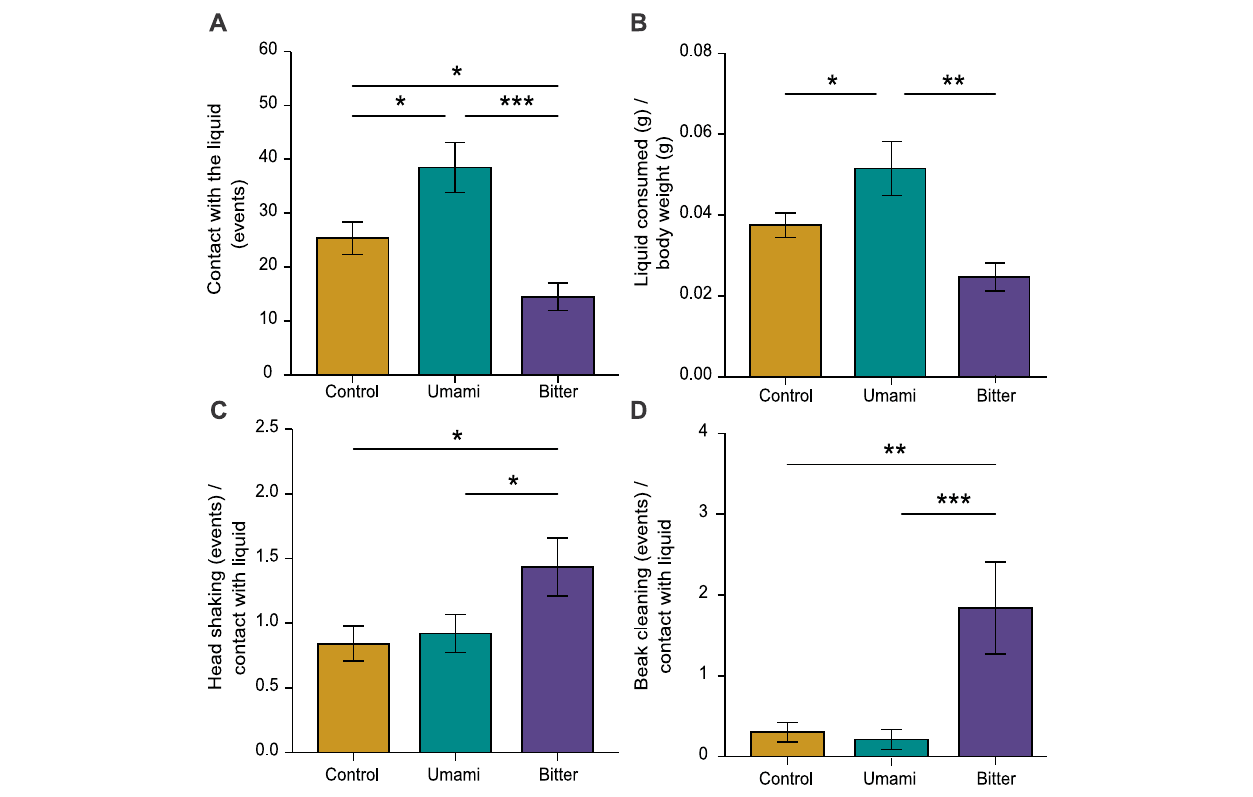
FIGURE 3 | Behavioural responses of chicks according to experimental tastes. (A) Contact with the liquid, (B) liquid consumed/body weight, (C) head shaking in relation to contact with the liquid and (D) beak cleaning in relation to contact with the liquid. Bar plots indicate mean ± s.e.m. ( p p < 0.05, pp p < 0.01, ppp p < 0.001).